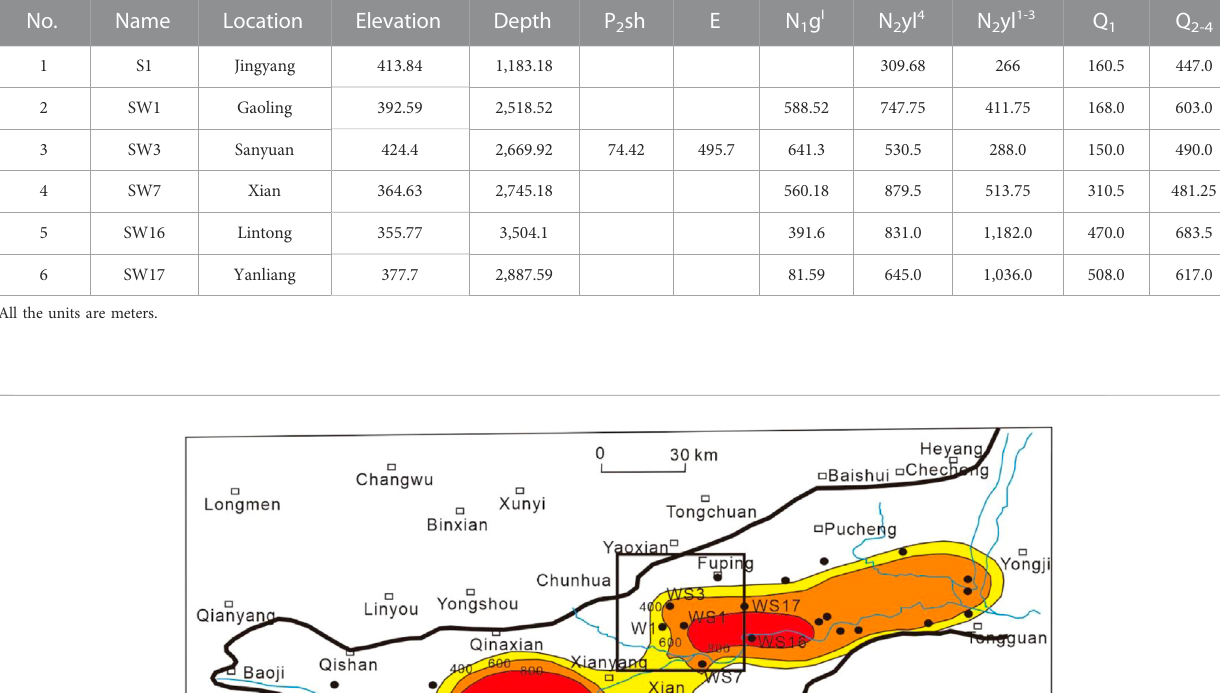
TABLE 4 Standard borehole detection and Quaternary stratigraphy in Weihe basin. No.